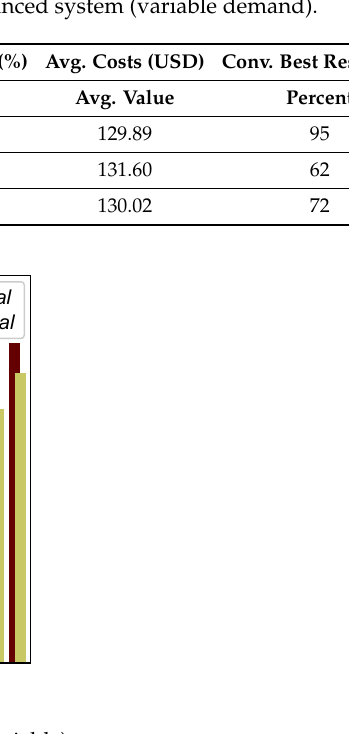
Figure 3. 33-bus and 37-branch system voltage levels